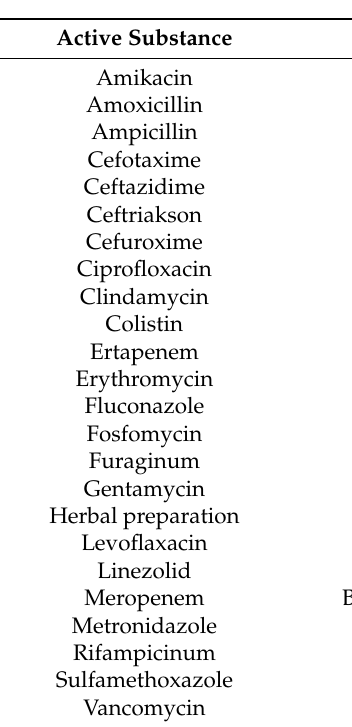
Table 8. Drugs used in the treatment of nosocomial